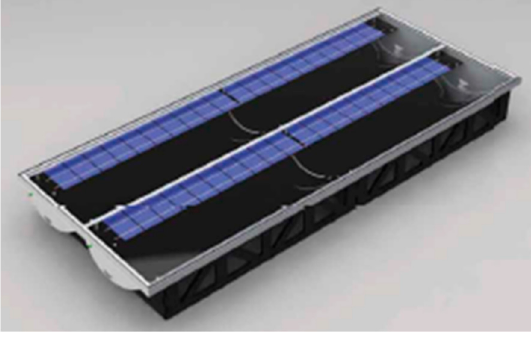
Figure 2. Prototype C-PVT collector.